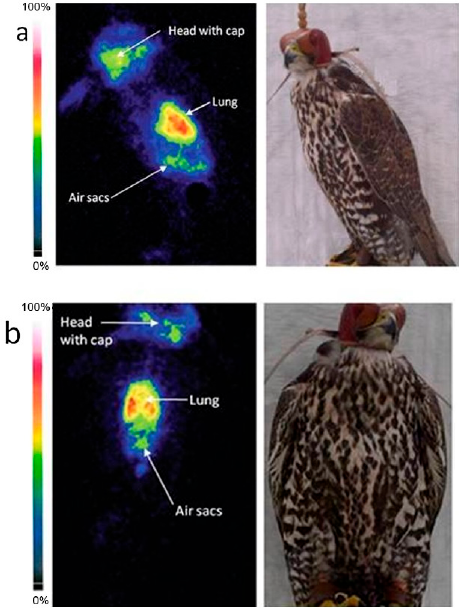
Figure 4. A gamma-camera image of a falcon after inhalation of the developed ITZ-NLC formulation from ( a ) the lateral side and ( b ) from dorsal side [79].